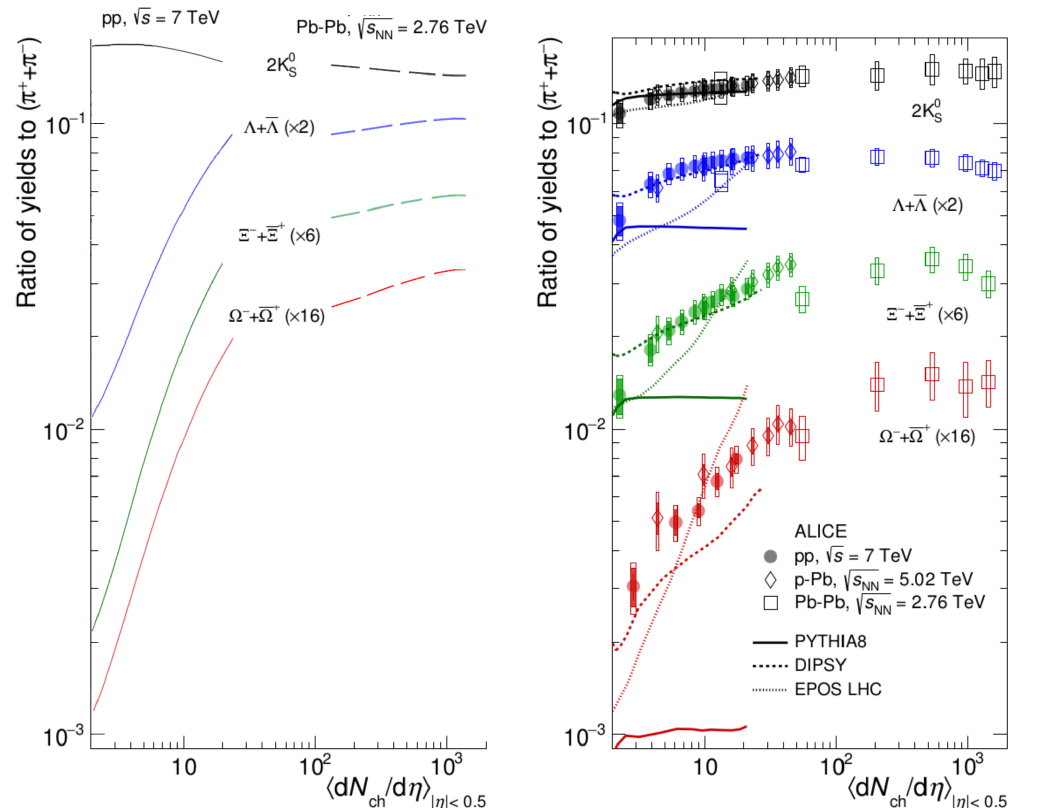
Figure 17. Multiplicity dependence of the strange and multi-strange particle yields ( K 0 s , Λ , Ξ , Ω ) di- vided by charged pion multiplicity. Left plot—our model calculation for pp collisions at (solid lines) and for Pb - Pb collisions (dashed lines) at experimental data (dots) and prediction of other